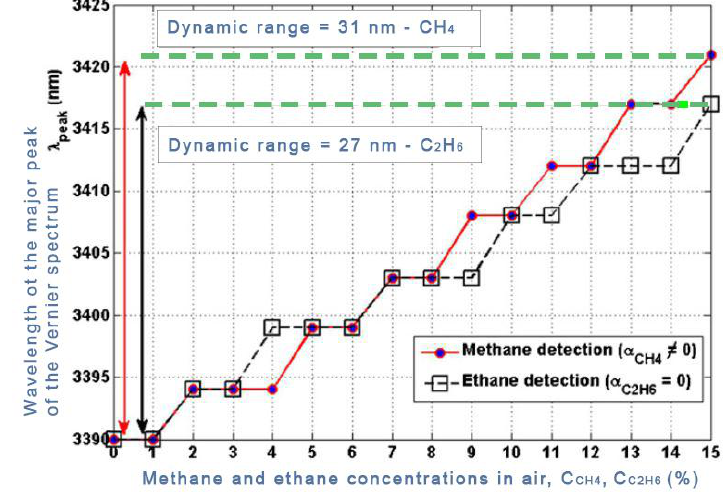
Figure 9. Operative functions of Vernier-based sensors for ethane and methane detection in